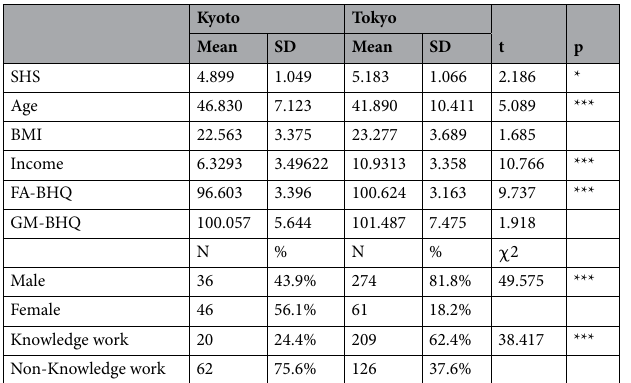
Table 1. Statistical differences between institutes for participation. n = 417; * p < 0.05; ** p < 0.01; *** p < 0.001.